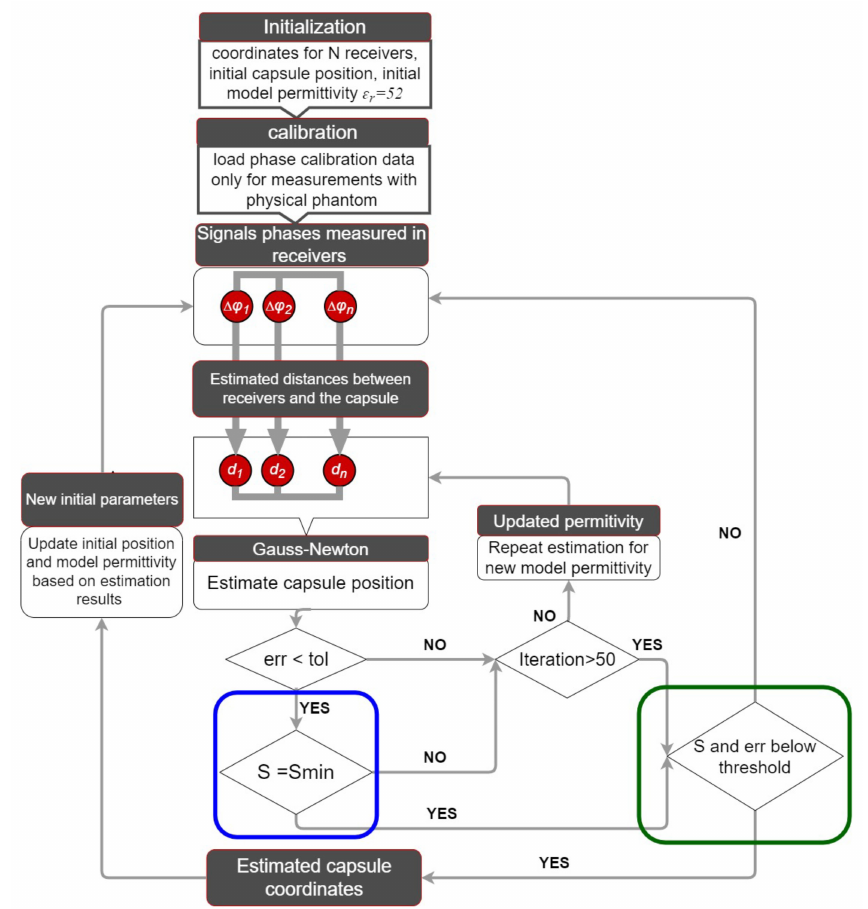
Figure 1. Improved localization algorithm with minimalization of S function marked in blue frame and results evaluation in green frame supplemented with calibration step for localization based on